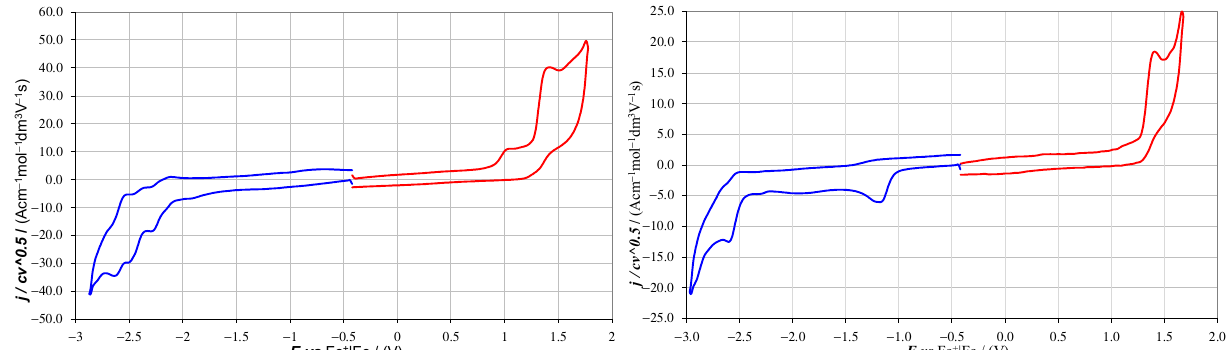
Figure 3. Normalized CV patterns obtained on glassy carbon electrode at a 0.2 V/s scan rate for 1 and 2 with 7.5 × 10 − 4 M in CH 3 CN + 0.1 M tetrabutylammonium hexafluorophosphate, TBAPF 6 (starting oxidative and reductive half-cycles, red and blue, respectively).